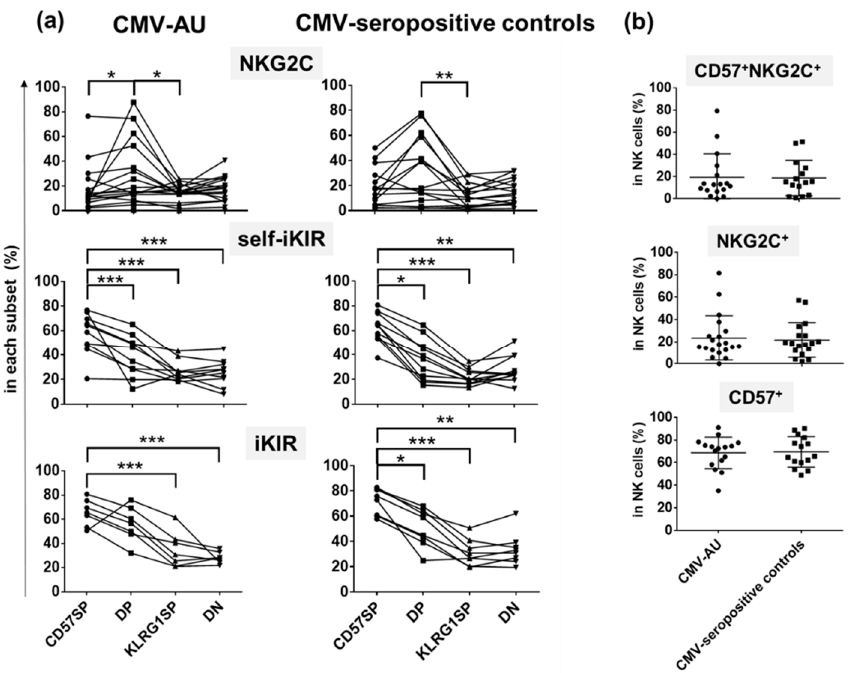
Figure 4. The four NK cell subsets defined by differential expression of CD57 and KLRG1 express disparate levels of NKG2C and iKIR. ( a ) Proportion of cells expressing NKG2C and iKIR on the four NK cell subsets. (CMV-AU, n = 15; CMV seropositive controls, n = 17. ANOVA: NKG2C, p = 0.047; self-iKIR, p = 0.0001; iKIR, p = 0.0006. Linear trend test: self-iKIR & iKIR, p < 0.0001). * p < 0.05, ** p < 0.01, *** p < 0.001. ( b ) Proportion of CD57 + NKG2C + , NKG2C + , CD57 + NK cells in CMV-AU and CMV-seropositive healthy individuals (CD57 + NKG2C + , CD57 + : CMV-AU, n = 17; CMV-seropositive controls, n = 15; NKG2C + : CMV-AU, n = 20; CMV-seropositive controls, n = 18). Data represent the mean ± standard deviation.